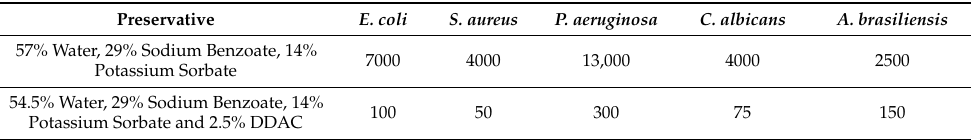
Table 4. MIC values (expressed in ppm) of 54.5% Water, 29% Sodium Benzoate, 14% Potassium Sorbate; and of 52% Water, 29% Sodium Benzoate, 14% Potassium Sorbate with addition of 2.5% Didecyldimethylammonium chloride cationic surfactants. Preservative E.